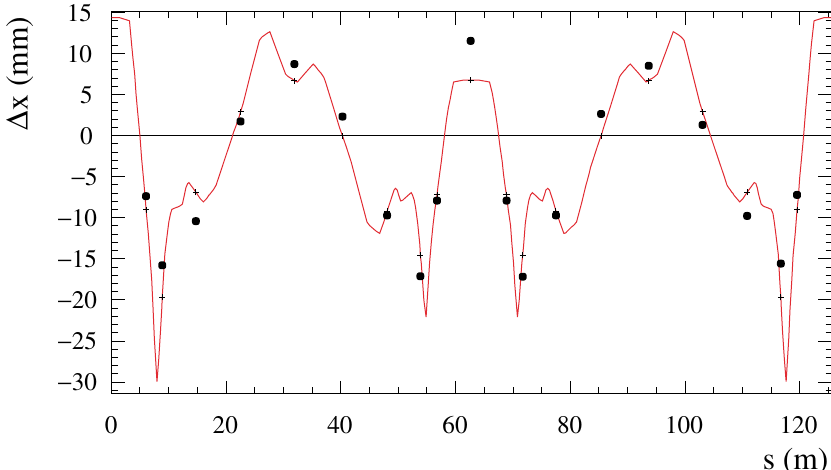
FIG. 14. (Color) Measured horizontal closed orbit difference (black points) for a change in frequency from 19.089 942 to 19.083 229 MHz. The solid line corresponds to the expected closed orbit difference, proportional to the dispersion calculated from a model with the measured magnet currents.